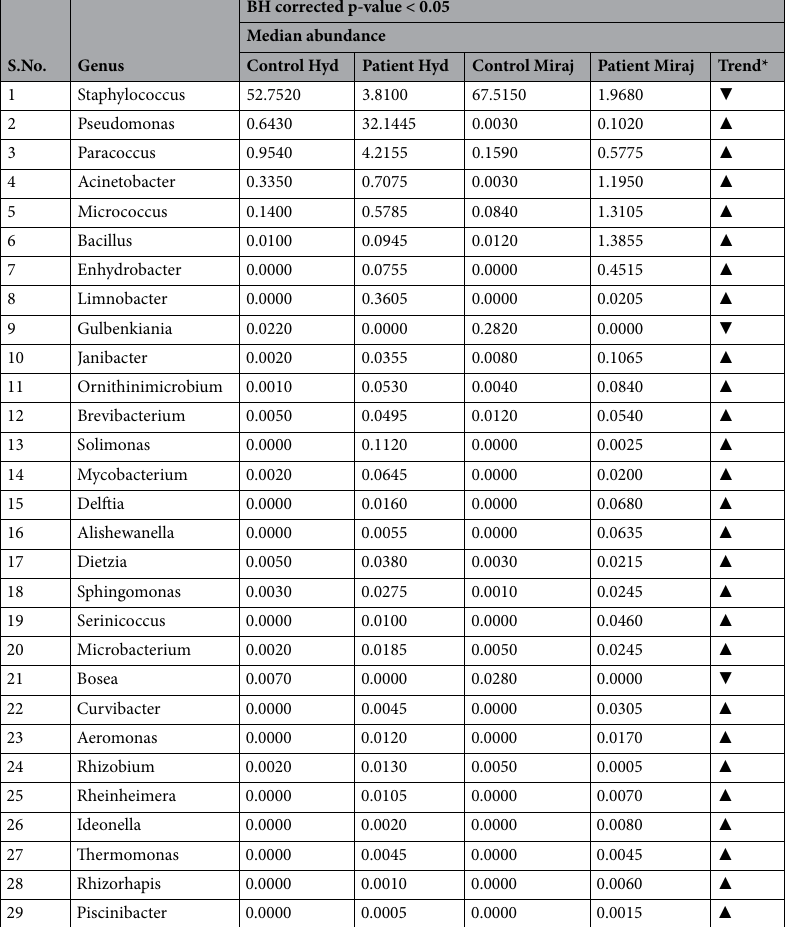
Table 1. Common differentiating genera between controls and patients from both geographies. *Trend refers to the relative change in leprosy patients, as compared to healthy